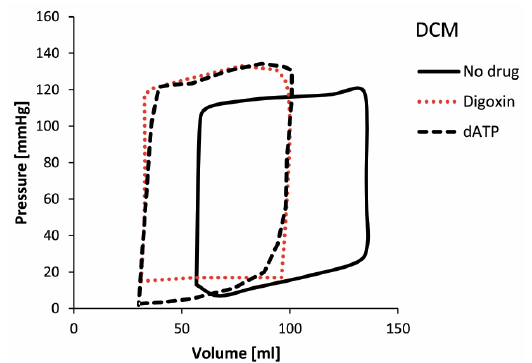
Figure 15. P-V diagrams for DCM at basic condition (without administered drug) and with using drugs Digoxin and dATP.